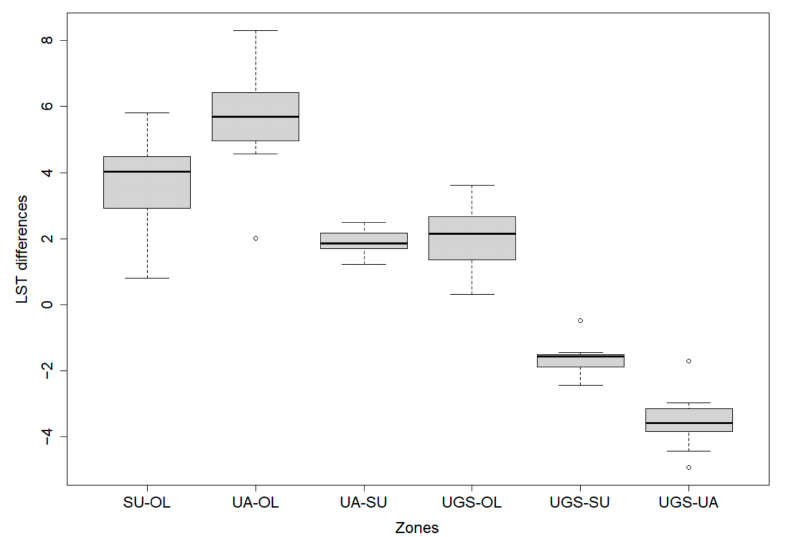
Figure 10. Comparison of average LST differences between pairs of zones for the entire evaluated